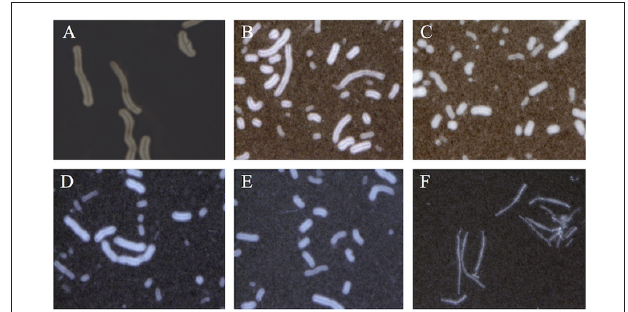
FIGURE 3 | Complementation effect of AcpA and AcpB on capsule formation in the pag null mutants. Microscope images of India ink stained Pasteur II strain (A) , acpA complementation strain in the pag promoter deletion mutant (B) , and acpA complementation strain in the pag null mutant (C) , acpB complementation strain in the pag promoter deletion mutant (D) , acpB complementation strain in the pag null mutant (E) , and negative control Sterne strain without capsule formation (F) . The images are representative of 3 independent experiments.